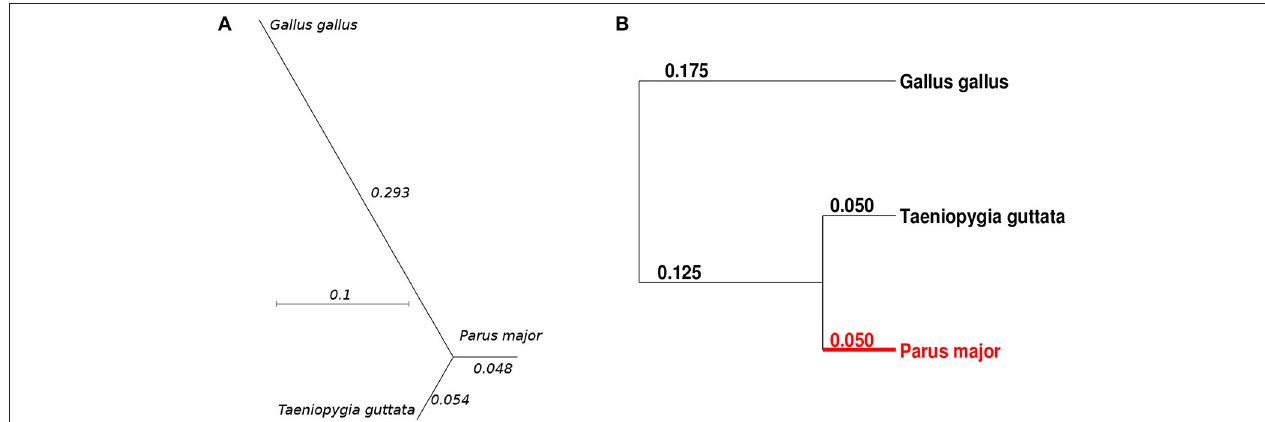
FIGURE 1 | Three species ( Parus major , Taeniopygia guttata , Gallus gallus ) tree topology and (A) branch estimates from a stationary GTR model using baseml and (B) the ultrametric branch lengths assumed for the sequence simulations. The terminal branch in red was assumed to be evolving under non-stationary GC